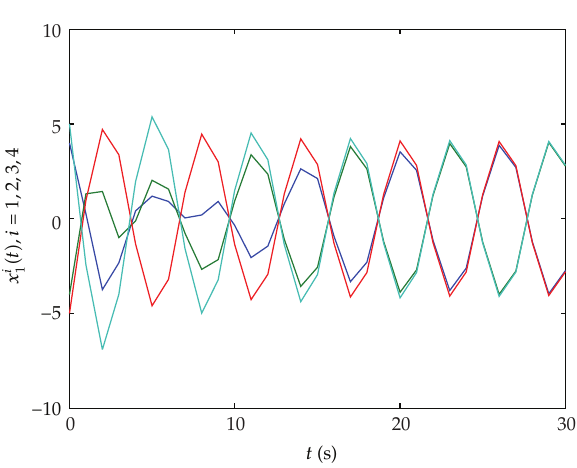
(cid:6) t (cid:7) , i (cid:9) 1 , 2 , 3 , 4 for G 1